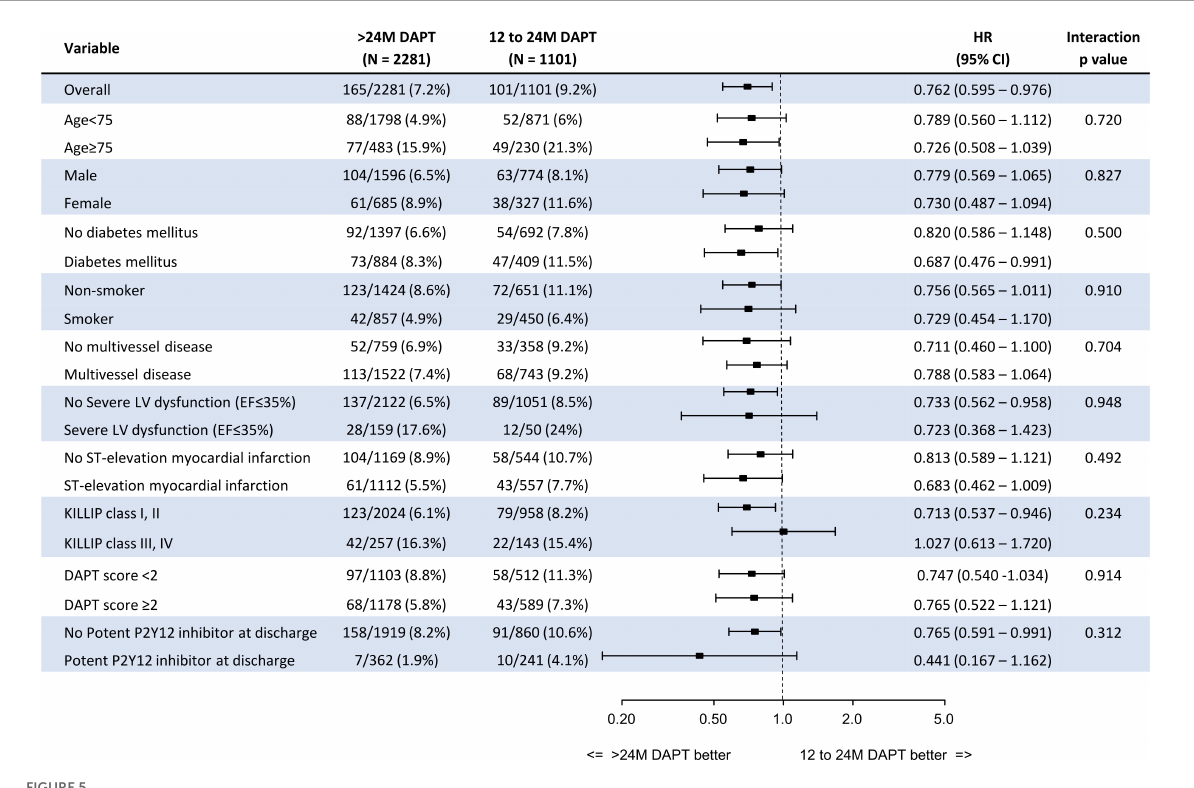
FIGURE5 Subgroup analysis. DAPT, dual antiplatelet therapy; HR, hazard ratio; LV, left